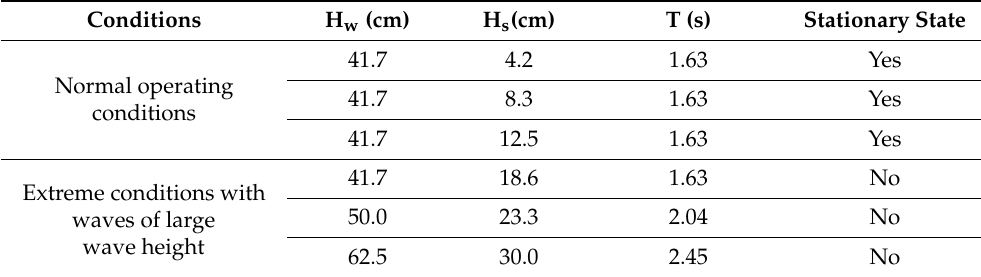
Table 4. Stationary state of the platform model.